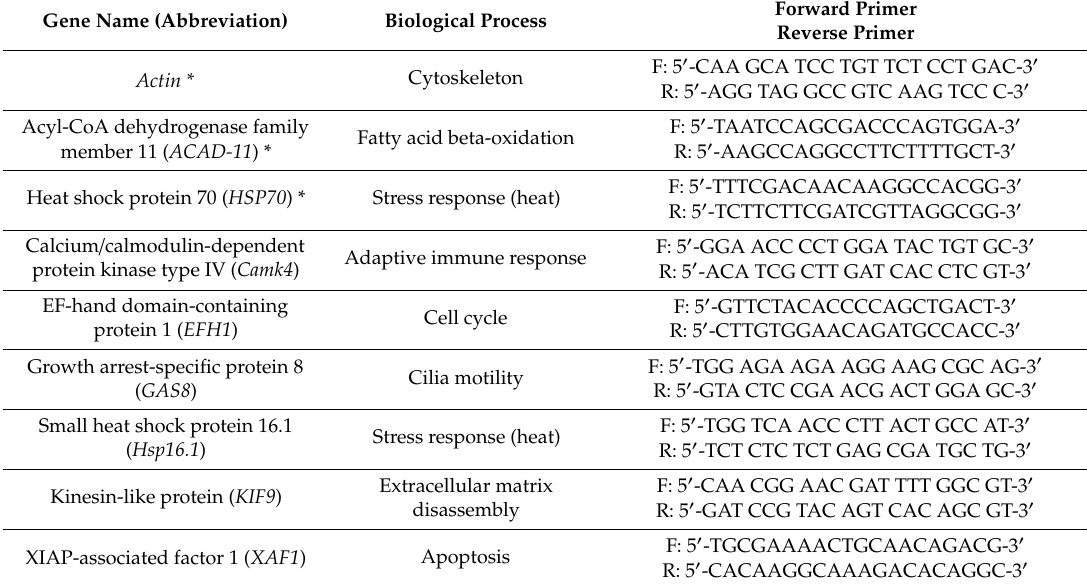
Table 1. List of genes of interest (GOIs) and internal control genes (ICGs) (*) with their corresponding functional profile (biological process) and primer